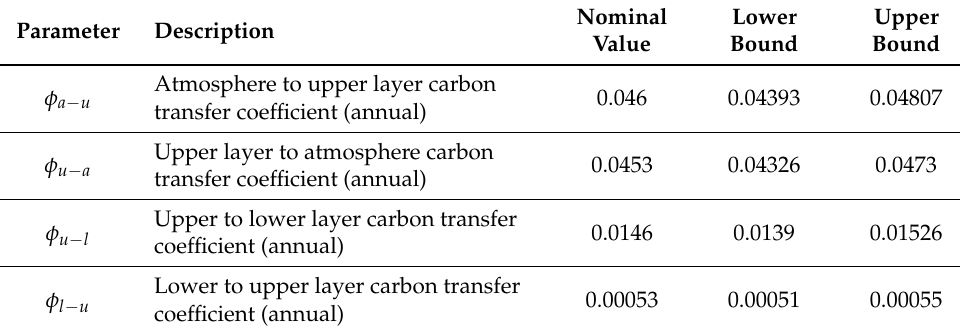
Table 1. Nominal values and bounds for climate